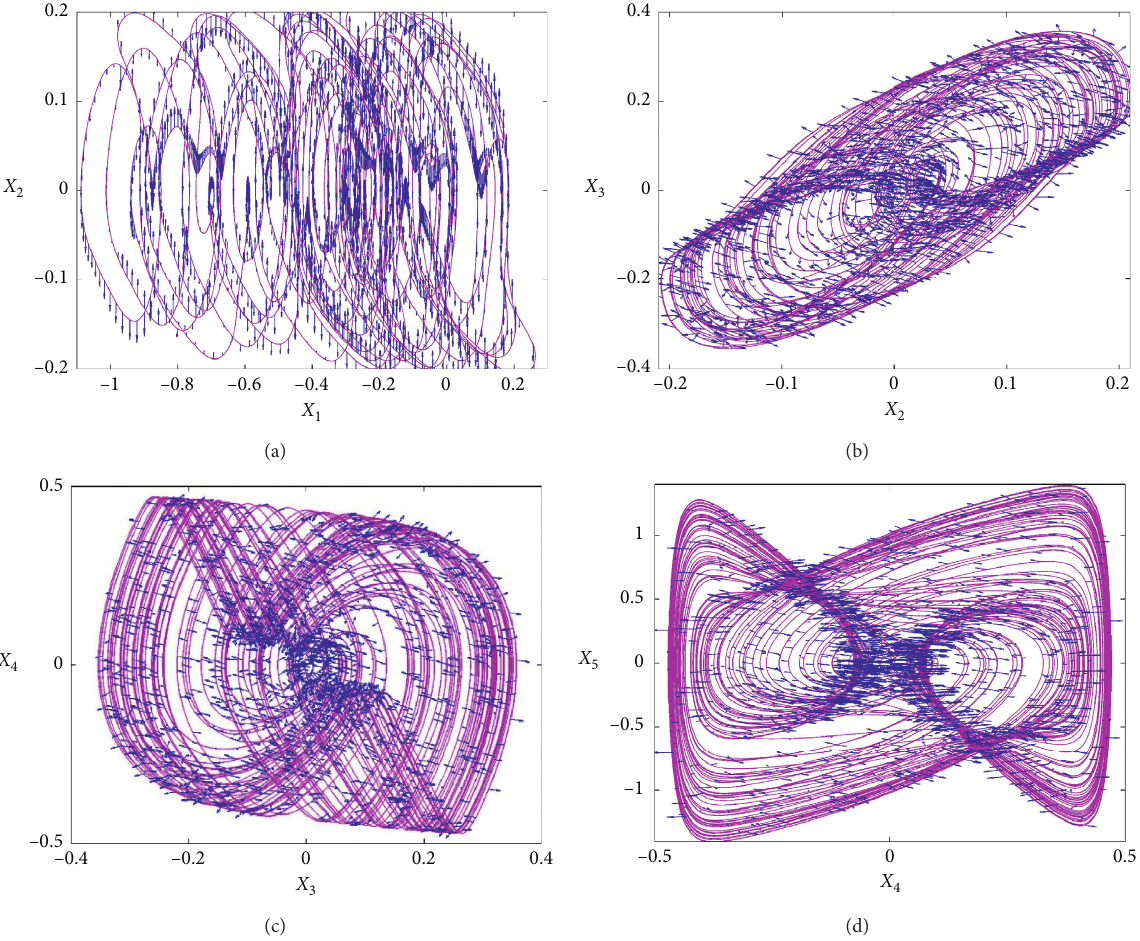
Figure 6: The negative Lyapunov vectors (LE4): (a) first and second components of negative Lyapunov vectors (LE4) in x second and third components of negative Lyapunov vectors (LE4) in x vectors (LE4) in x